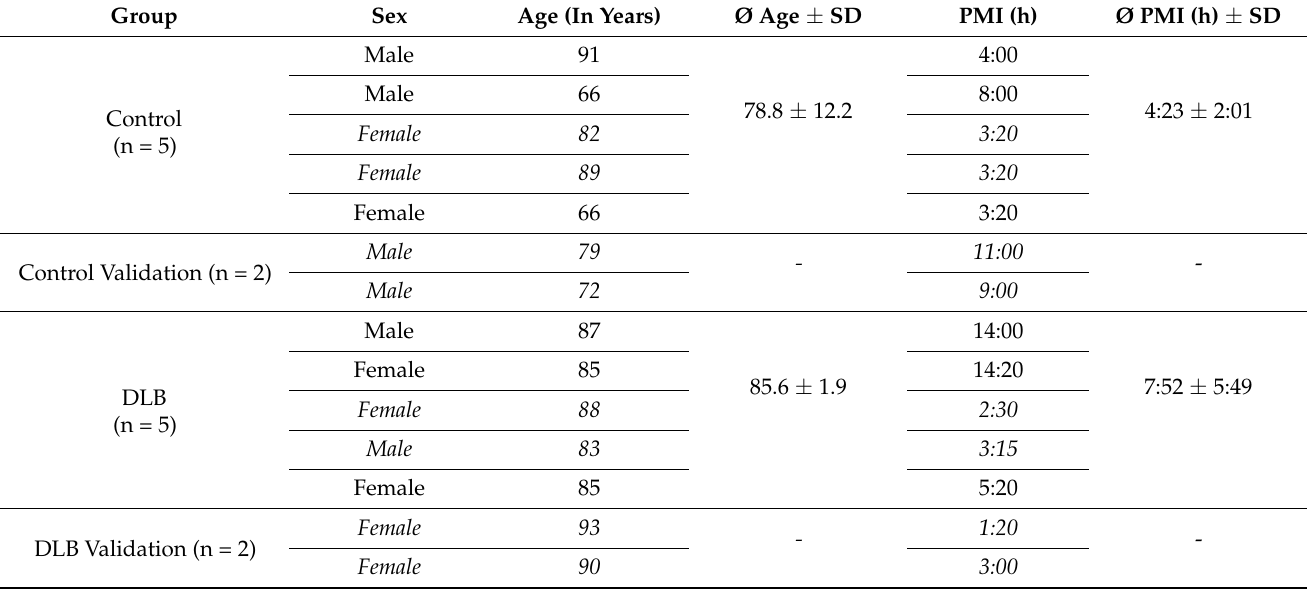
Table 1. Information of study